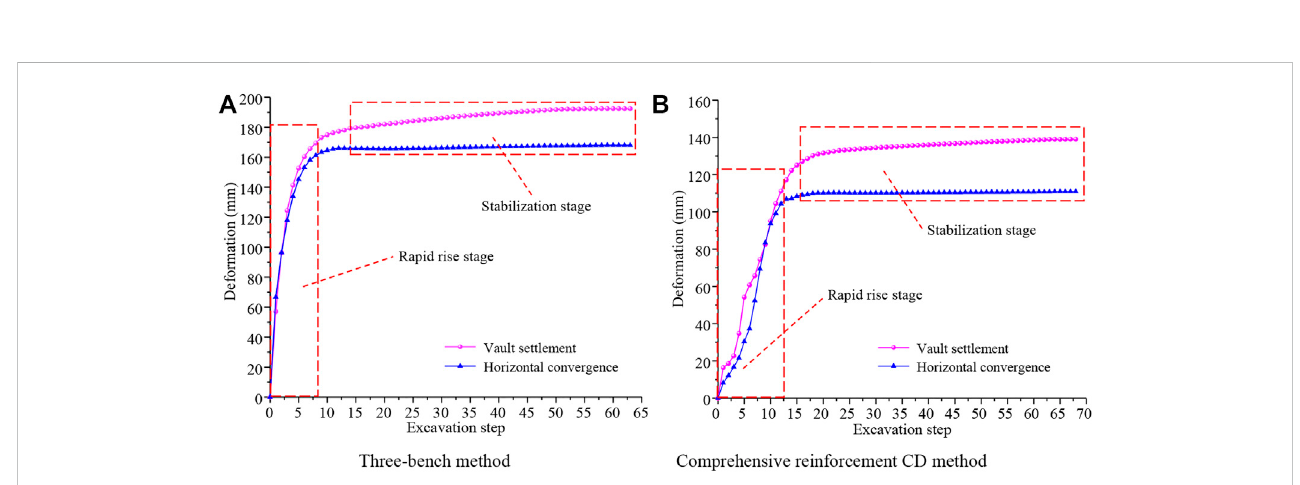
FIGURE 9 Deformation curves of surrounding rock under two working conditions. (A) Three-bench method (B) CD method.